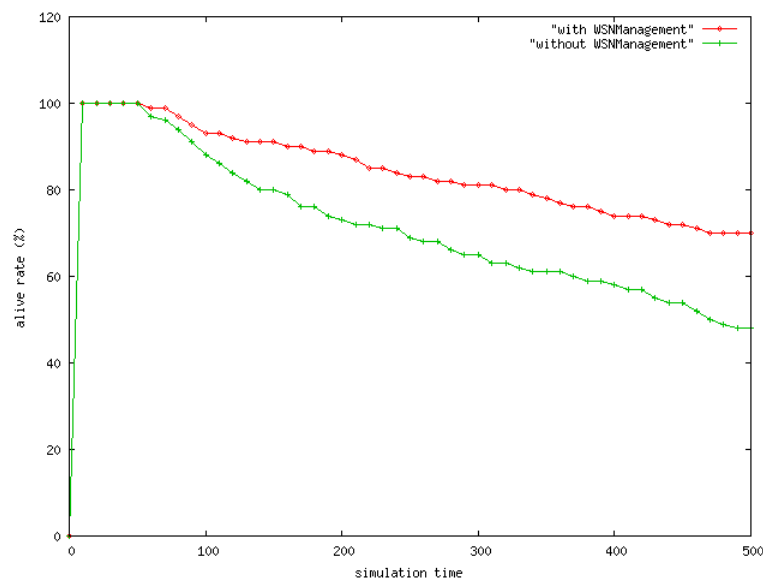
Figure 11. System Alive